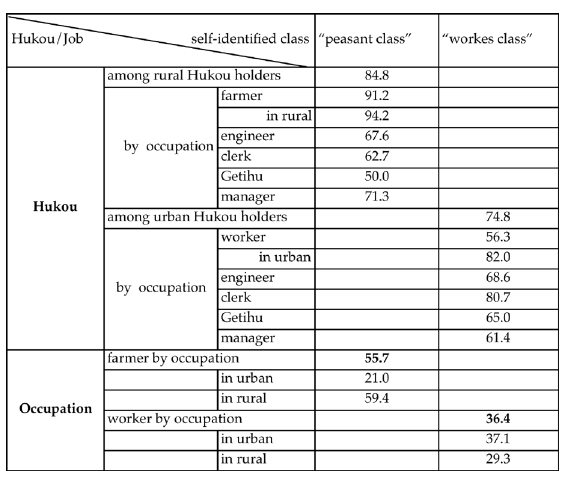
Table 2. Twisted Class